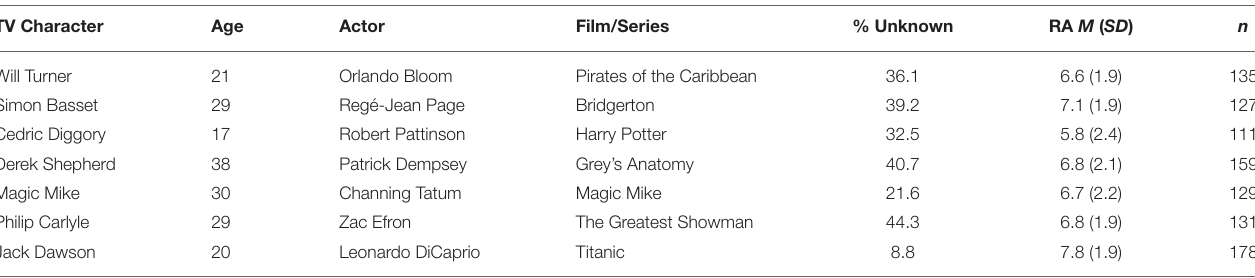
TABLE 6 | Final selection of included heroic TV characters in Study 2 (Main